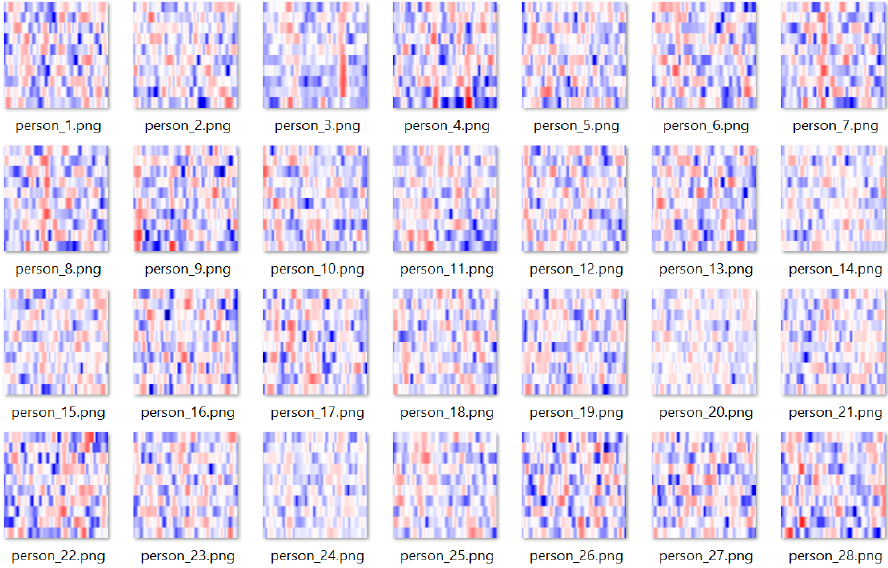
Figure A1. A set of pictures (TFR using Morlet wavelets) for relaxation for each participant—averaged values from all electrodes.